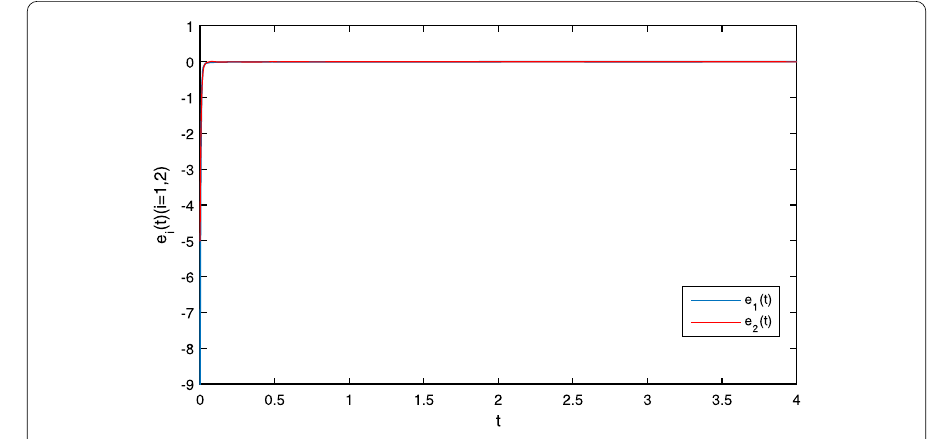
Figure 8 The synchronization errors e i ( t ) ( i = 1,2) state with β = 3